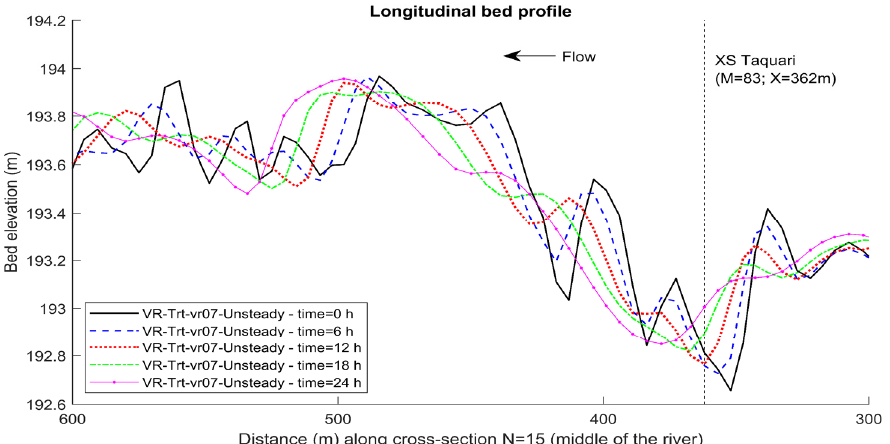
Figure 17. Temporal variation of a longitudinal bed profile from Delft3D simulations using Van Rijn formulations.